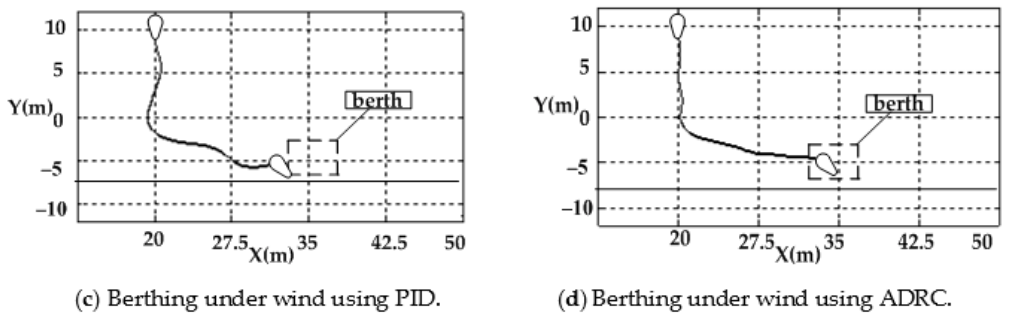
Figure 11 . Ship trajectory in the simulation of ship automatic berthing.